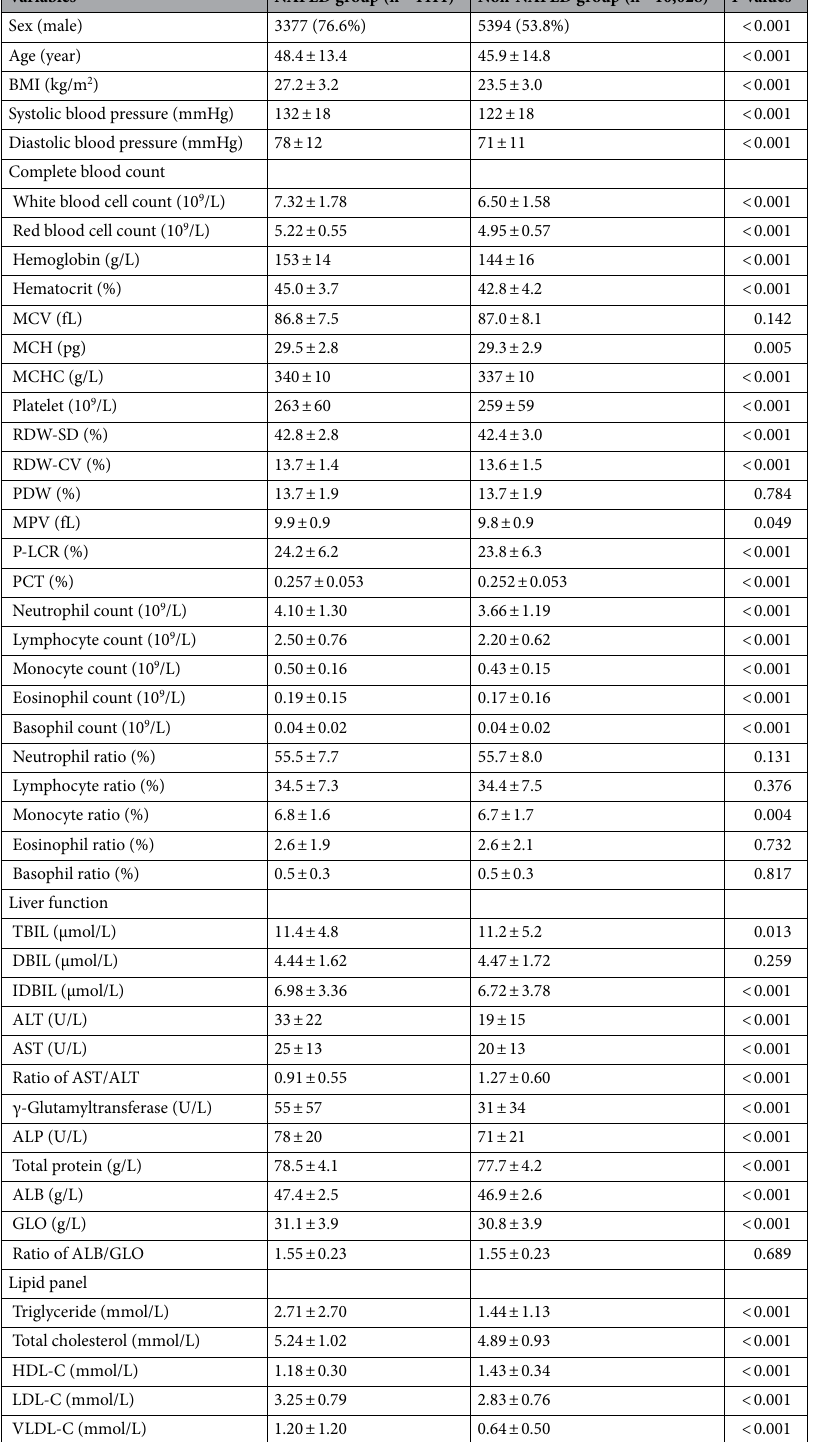
Table 1. Subjects characteristics in NAFLD group and non-NAFLD group. BMI body mass index; MCV mean corpuscular volume; MCH mean corpuscular hemoglobin; MCHC mean corpuscular